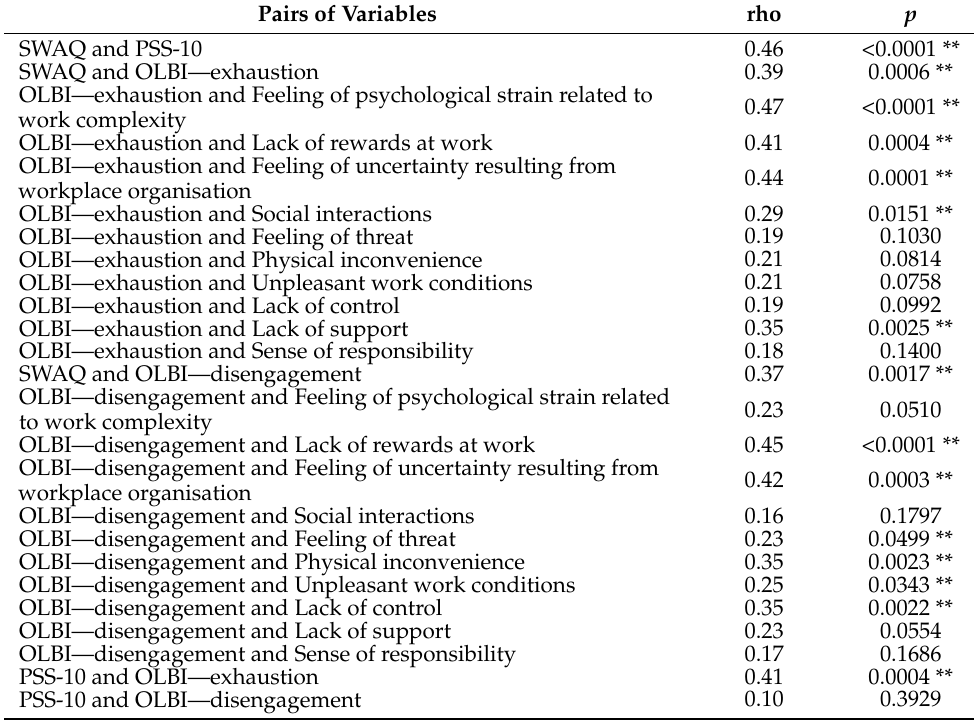
Table 6. The Spearman correlations between selected pairs of